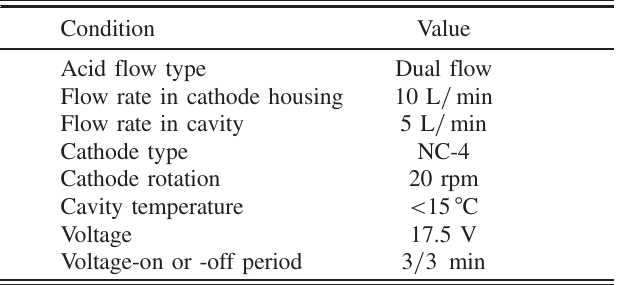
TABLE IV. Parameters applied for VEP of the nine-cell coupon